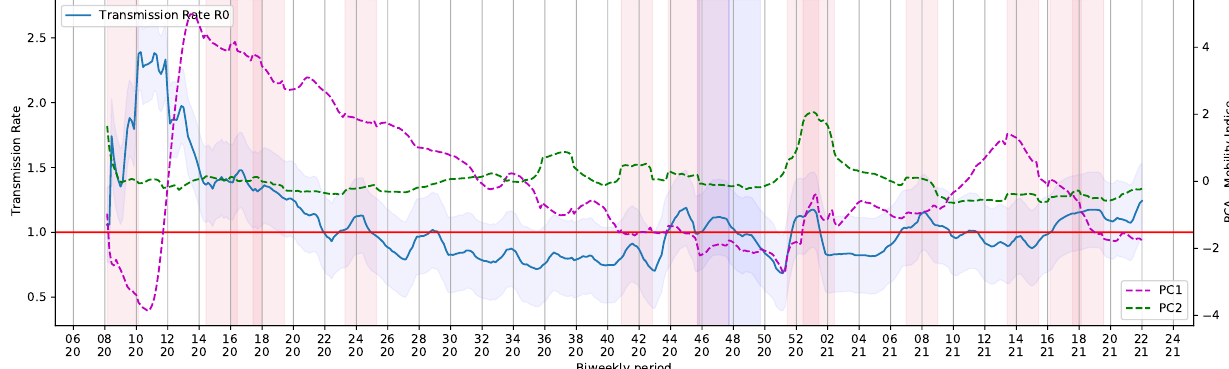
Figure 13. PC 1 and PC 2 shown with Basic Reproduction Number R 0 during the COVID-19 timeline in Brazil.